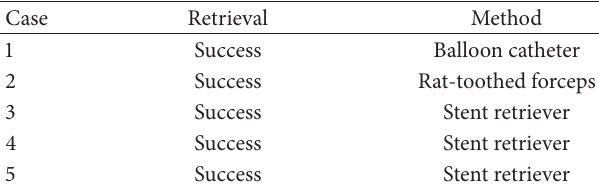
Table 5: Stents retrieval of migrated cases.